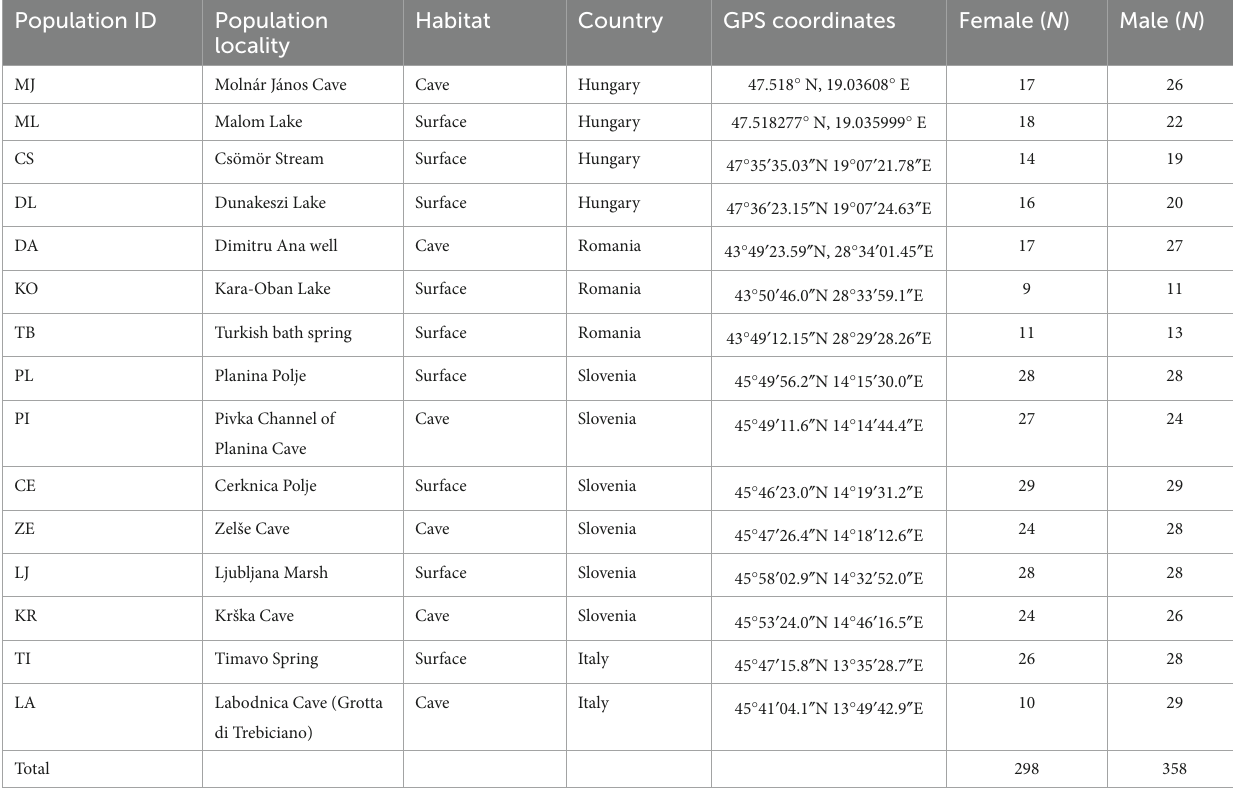
TABLE 1 Sampled Asellus aquaticus populations and sample